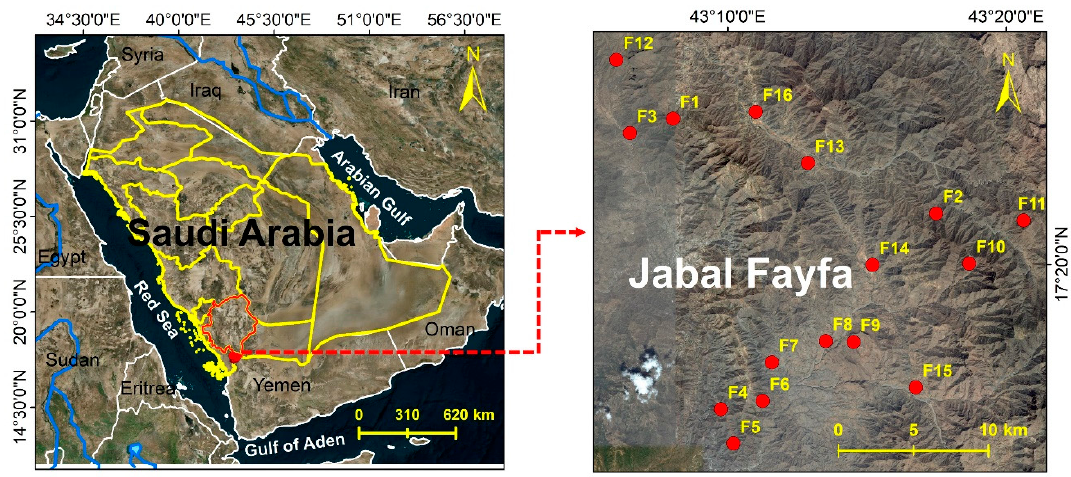
Figure 1. Location map of the study area of Jabal Fayfa showing the sampling sites (red).